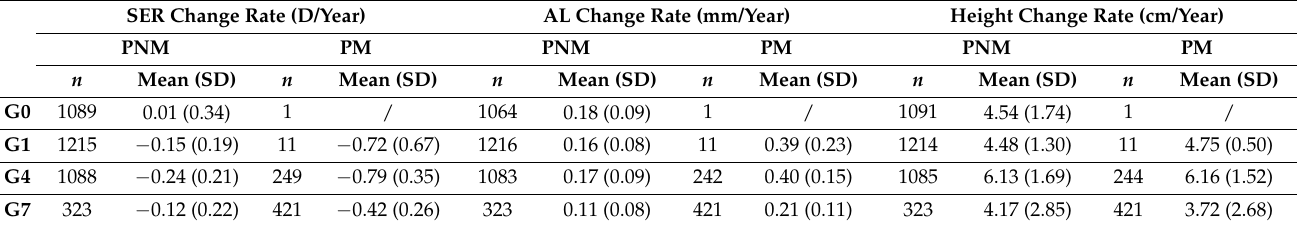
Table 2. SER, AL and body height change during two-year follow-up.